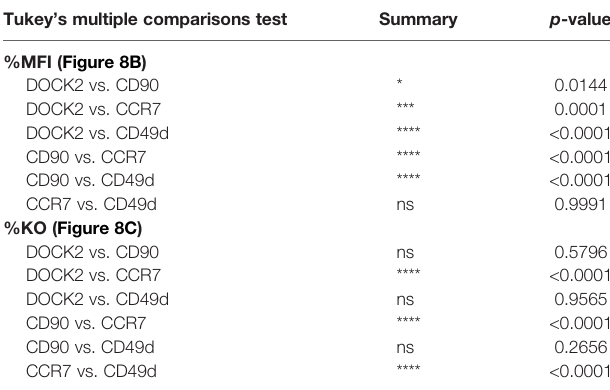
TABLE 2 | Result of statistical test for Figures 8B , C